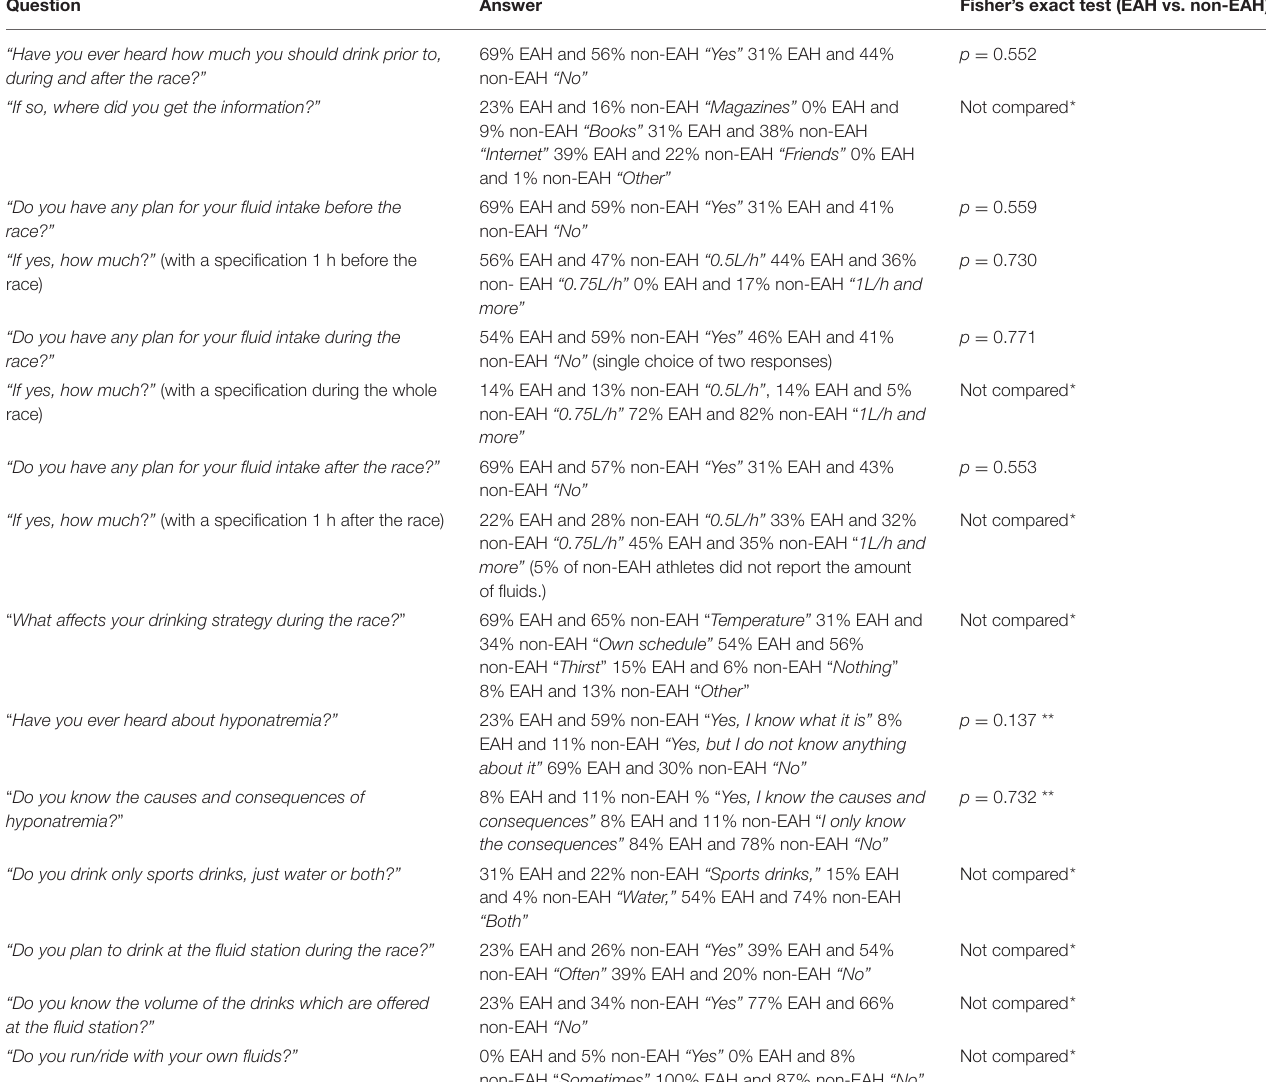
TABLE 3 | Percentage of answers regarding pre-, mid- and post-race drinking strategies; planned type and volume of fluids to be consumed; source of information on fluid intake and knowledge of EAH in the hyponatremic (EAH) ( n = 13) and normonatremic (non-EAH) ( n = 100) groups. Question